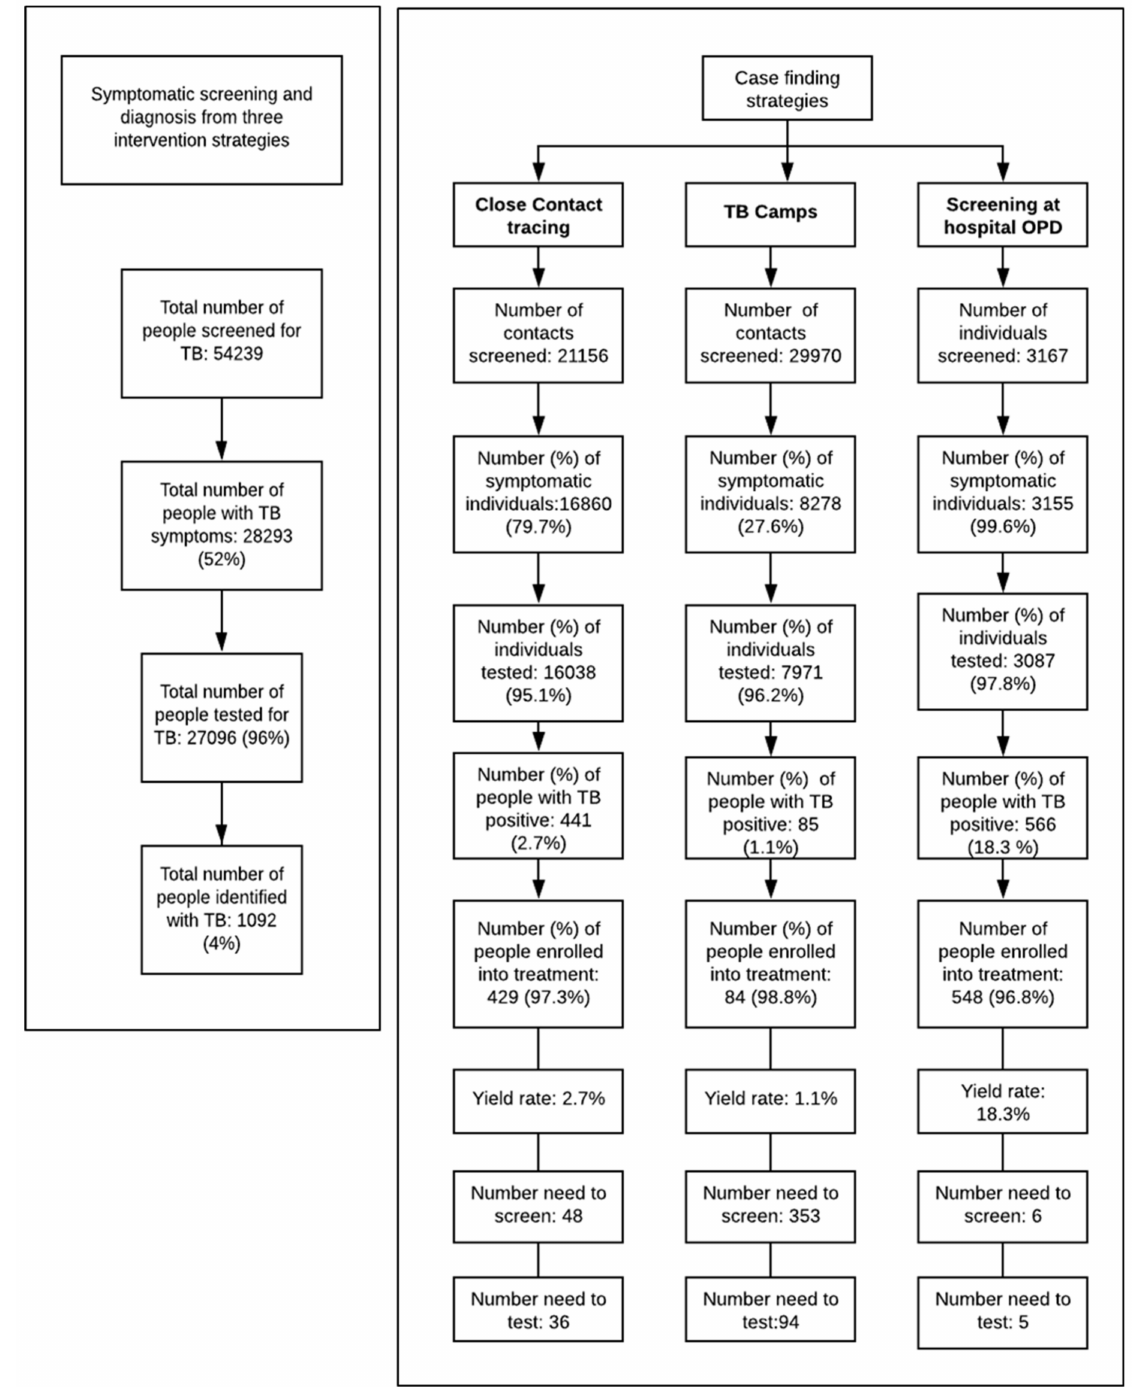
Figure 1. Flowchart showing the screening to diagnosis and treatment process in the intervention district. During the implementation period, among the three interventions, screening through the four hospital OPDs that used GeneXpert for TB diagnosis identified the highest propor- tion of TB cases (n = 566/1092; 52% cases). Contact tracing in all eight districts yielded a to- tal of 441 cases (40.4% n = 441/1092), and 62 TB camps yielded 85 cases (7.8%; n = 85/1092). The NNS was lowest for the OPD strategy (NNS = 6), with NNS = 48 for contact tracing, and NNS = 353 for TB camps. The NNT was just 5 for the OPD strategy, 36 for contact tracing, and 94 for TB